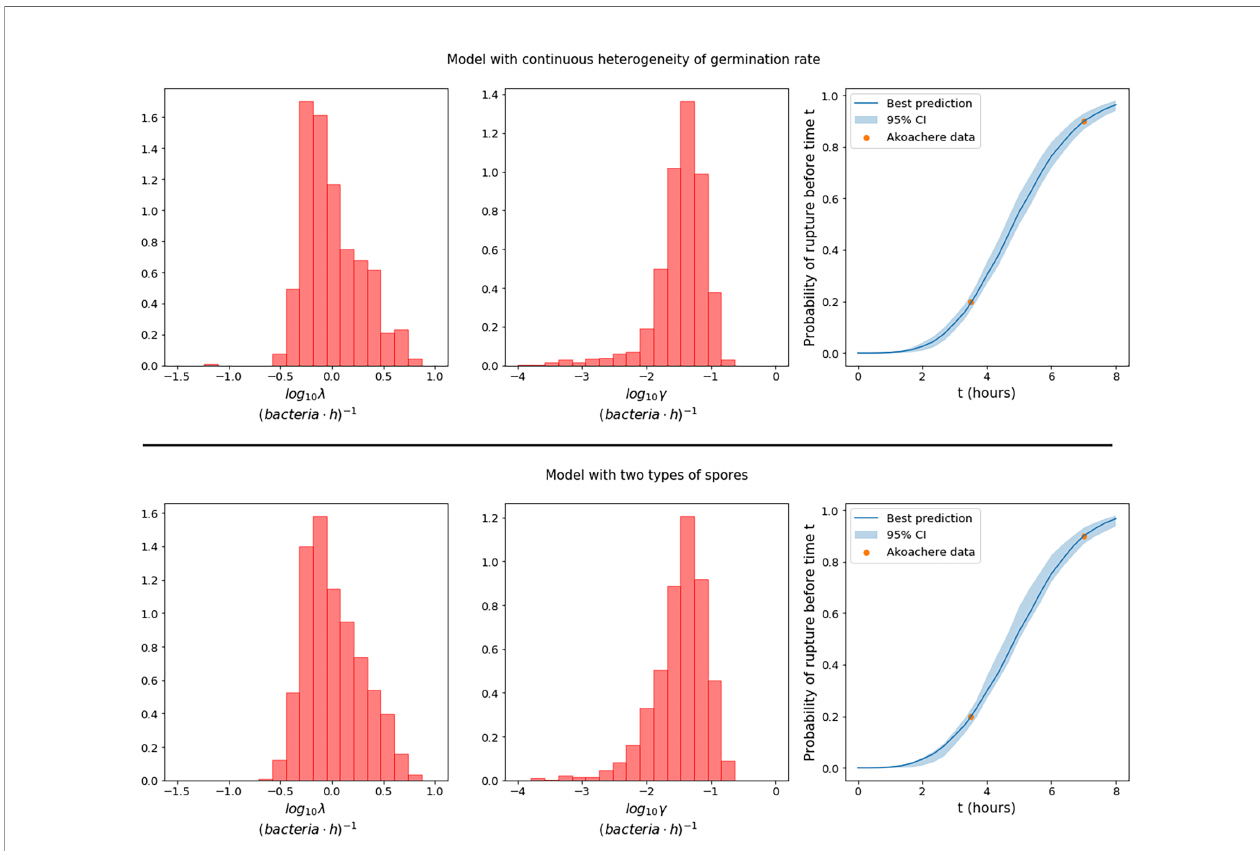
FIGURE 2 | Prior distributions for the replication rate, l , and the rupture rate g , in the model with continuous heterogeneity of germination rate (top row), and the model with two types of spores (bottom row), obtained by using observations from Akoachere et al. (26) of the proportion of dead macrophages at two different time points. The plots on the right show the best predictions (solid line) of the fraction of cells that would be expected to rupture before time t in an experiment with MOI 20:1, compared to the data from Akoachere et al. (26). The pointwise 95% credible intervals (shaded region) are shown to represent the uncertainty in the parameter